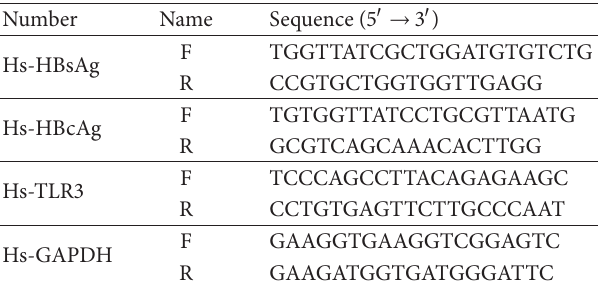
Table 1: The primers used in the experiments. Table 2: TLR3 expression in HCC and ANT